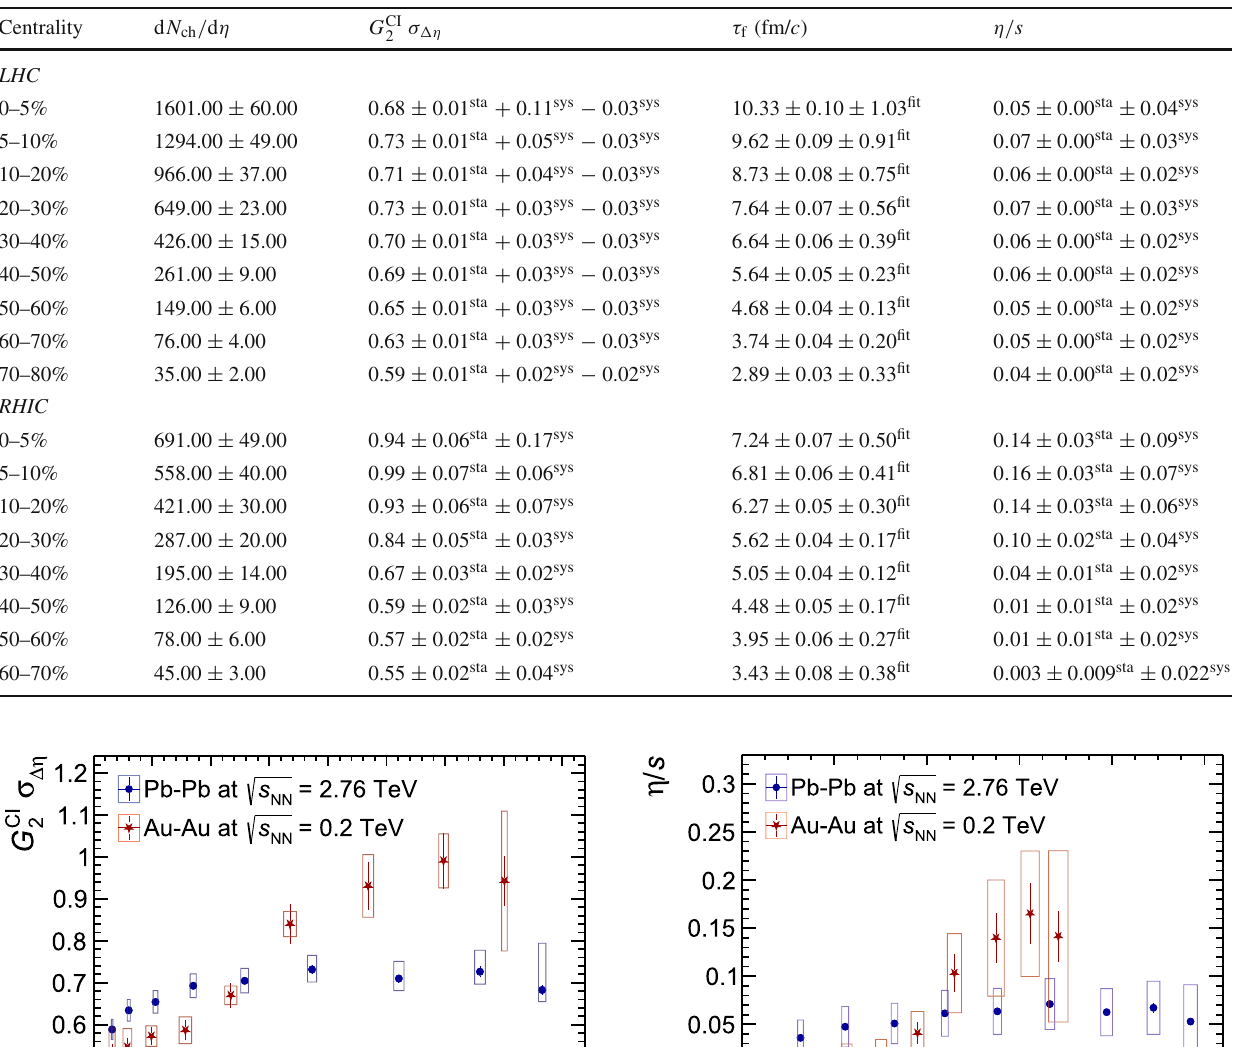
Table 1 Compilationofmeasured charged particledensities, d N ch / d η , and longitudinal widths, σ (cid:8)η , of the G CI out times, τ f , and computed values of η/ s as a function of the centrality